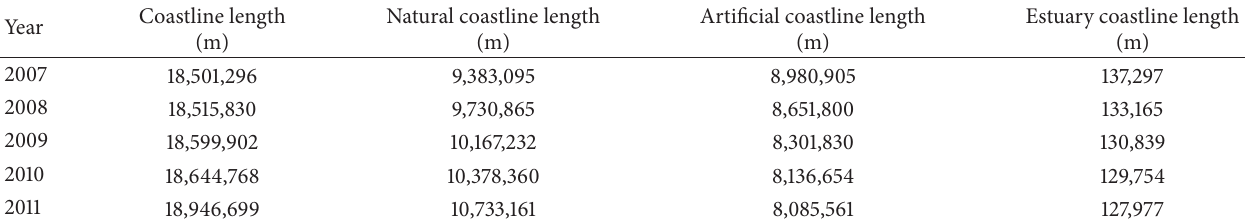
Table 2: The analytical coastline length of China based on remote sensing from 2007 to 2011.